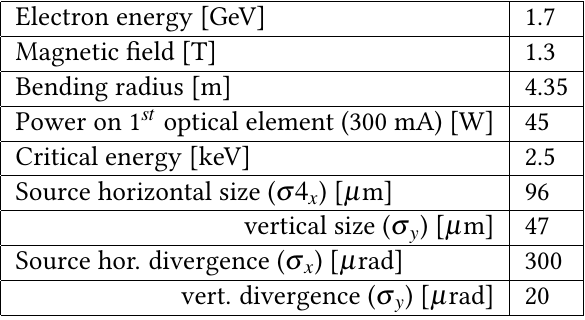
Table 1: BESSY II source characteristics of the dipole section DIP 1.1.